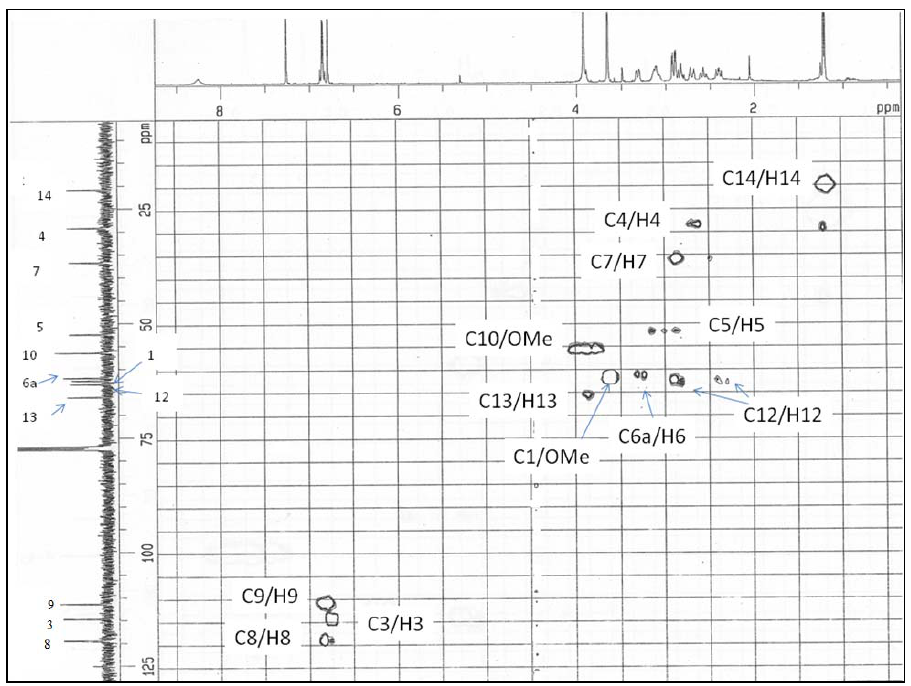
Figure 4. HMQC spectrum of alkaloid 1